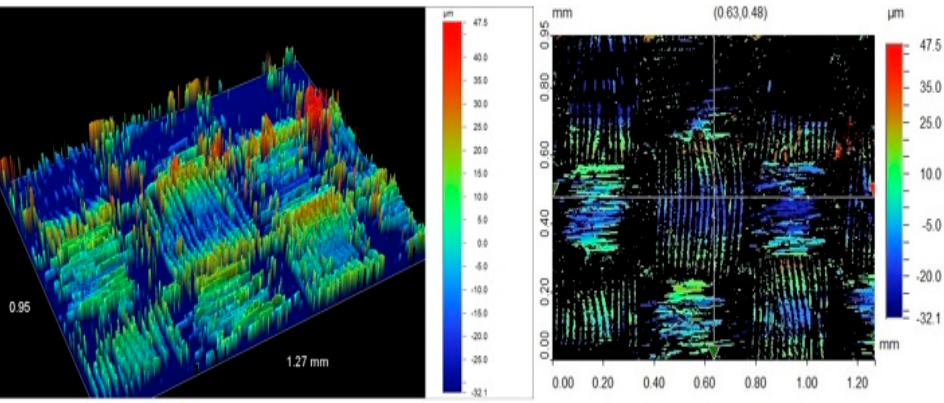
Figure 12. 3-D and 2-D images of topographic surface of CFRP strip with PCA.